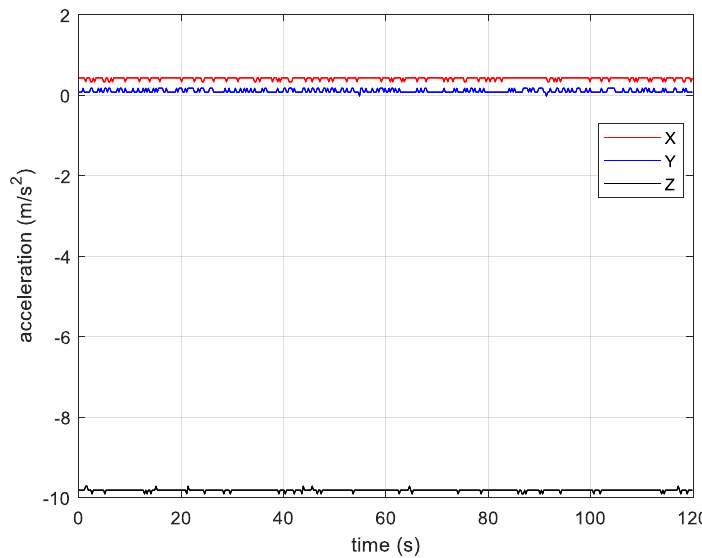
Figure 6. Raw accelerometer data (static test, no filtering). The nonzero x - and y -components are due to non-optimal alignment between the accelerometer axes and the body reference system.